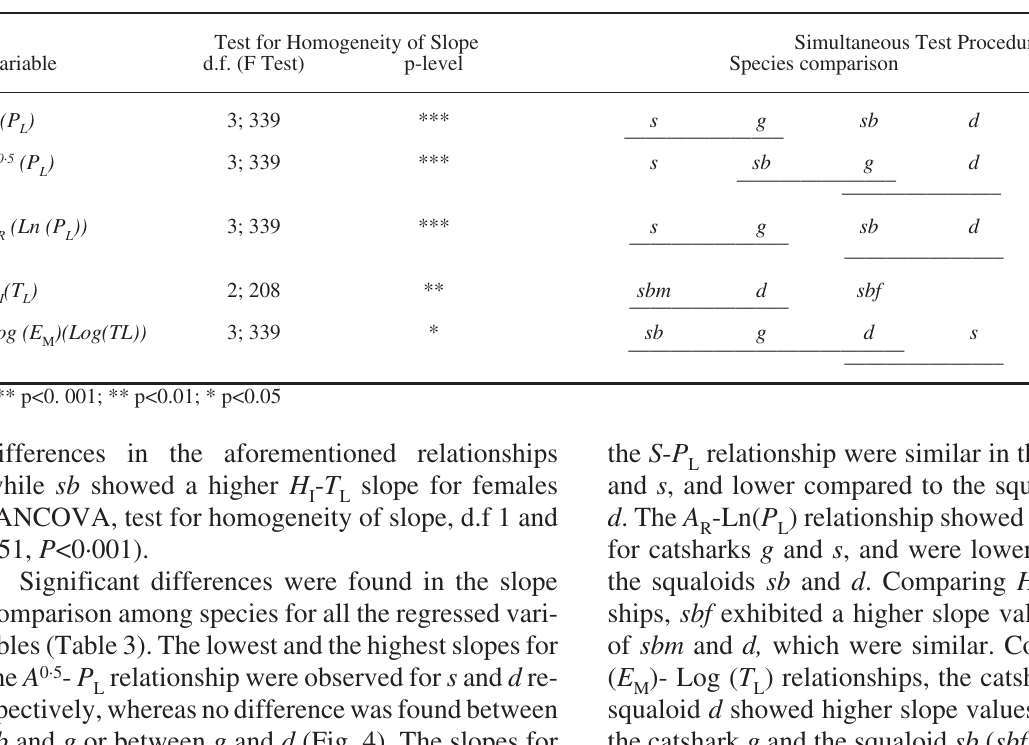
Table 3. – results of the comparison of regression slopes of caudal fin span ( S ), transformed caudal area ( A 0·5 ), aspect ratio ( A ic index ( H ) and log-transformed eviscerated mass ( Log E i sf : females; sm : males) and Dalatias licha ( d ). Variables used as covariates in each analysis are shown in parentheses: P ln ( P ): natural logarithmic transformed pre-caudal length; T l